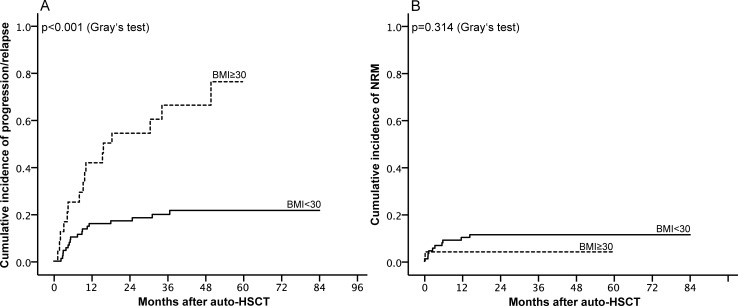
(A) Cumulative incidence of non-relapse related mortality (NRM) and (B) Cumulative incidence of relapse/progression, each stratified by BMI < 30 (solid line) and ≥ 30 (dotted line).